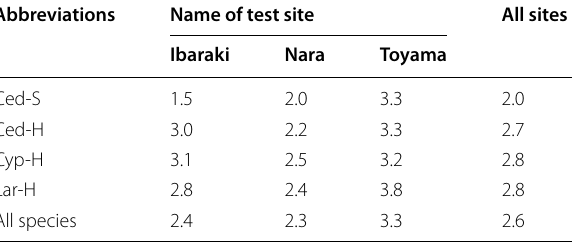
Table 4 Service life evaluated by the conventional